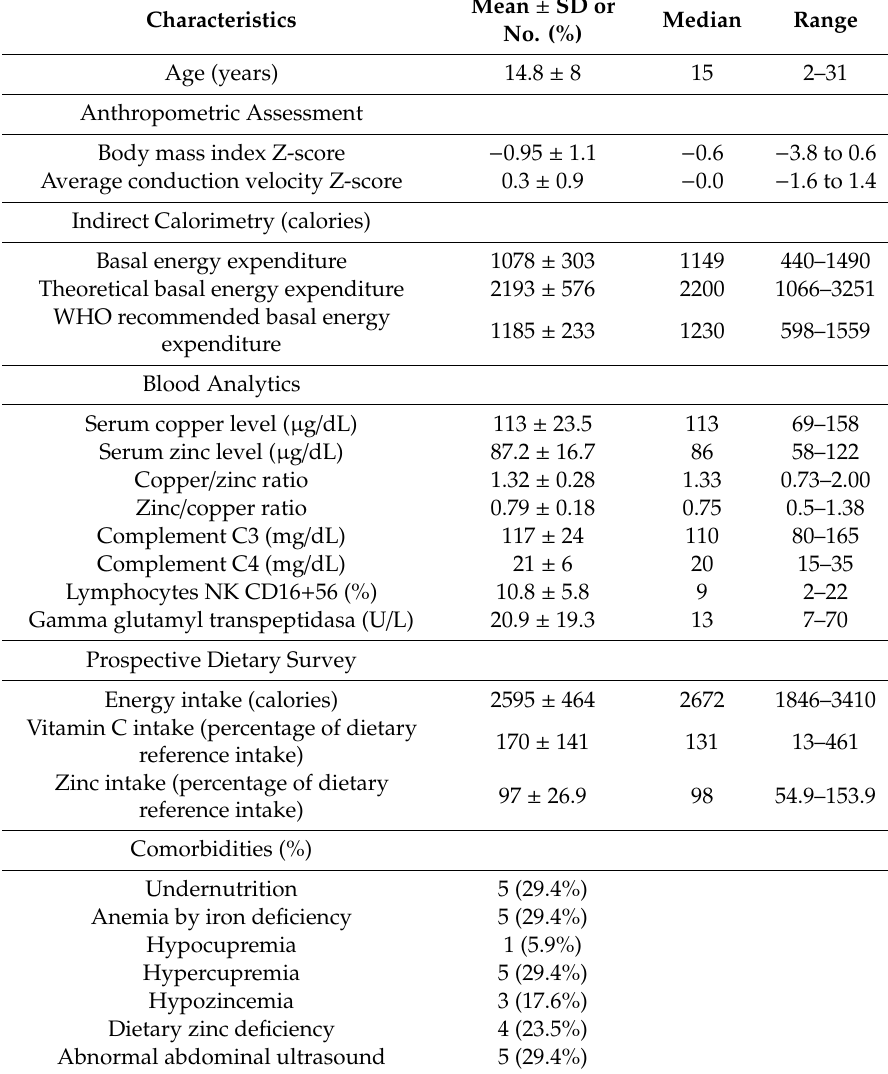
Table 1. Baseline demographic and clinical characteristics of participants ( n = 17 *)